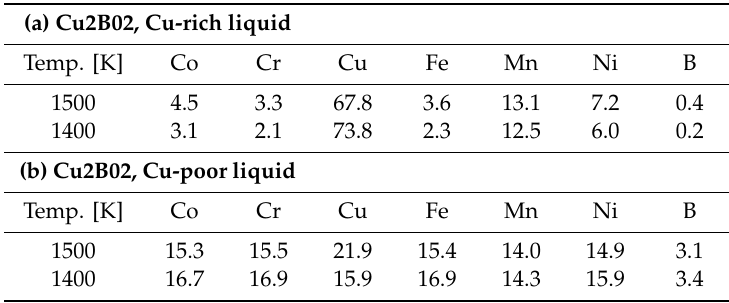
Table 4. Chemical composition of the separated liquid in CoCrCu 2 FeMnNiB 0.2 (Cu2B02) alloys estimated by the thermodynamic calculations. (a) Cu-rich liquids, (b) Cu-poor